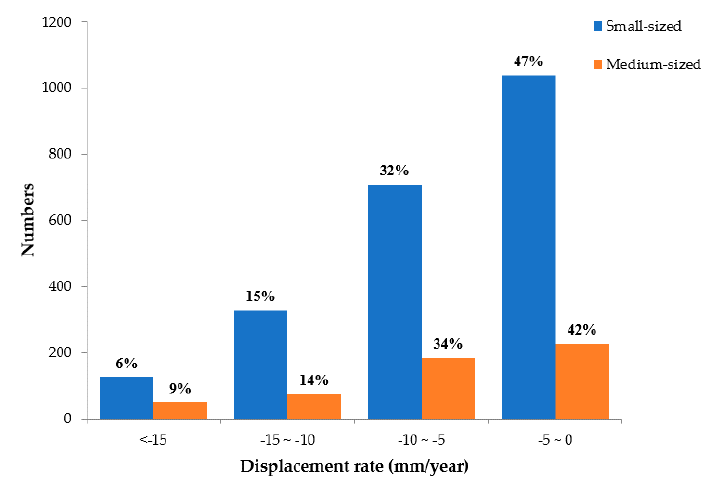
Figure 12. Number of pixels according to 4 classes of displacement rates for small and medium-scale mines estimated by the SBAS-InSAR technique from 2006 to 2011.